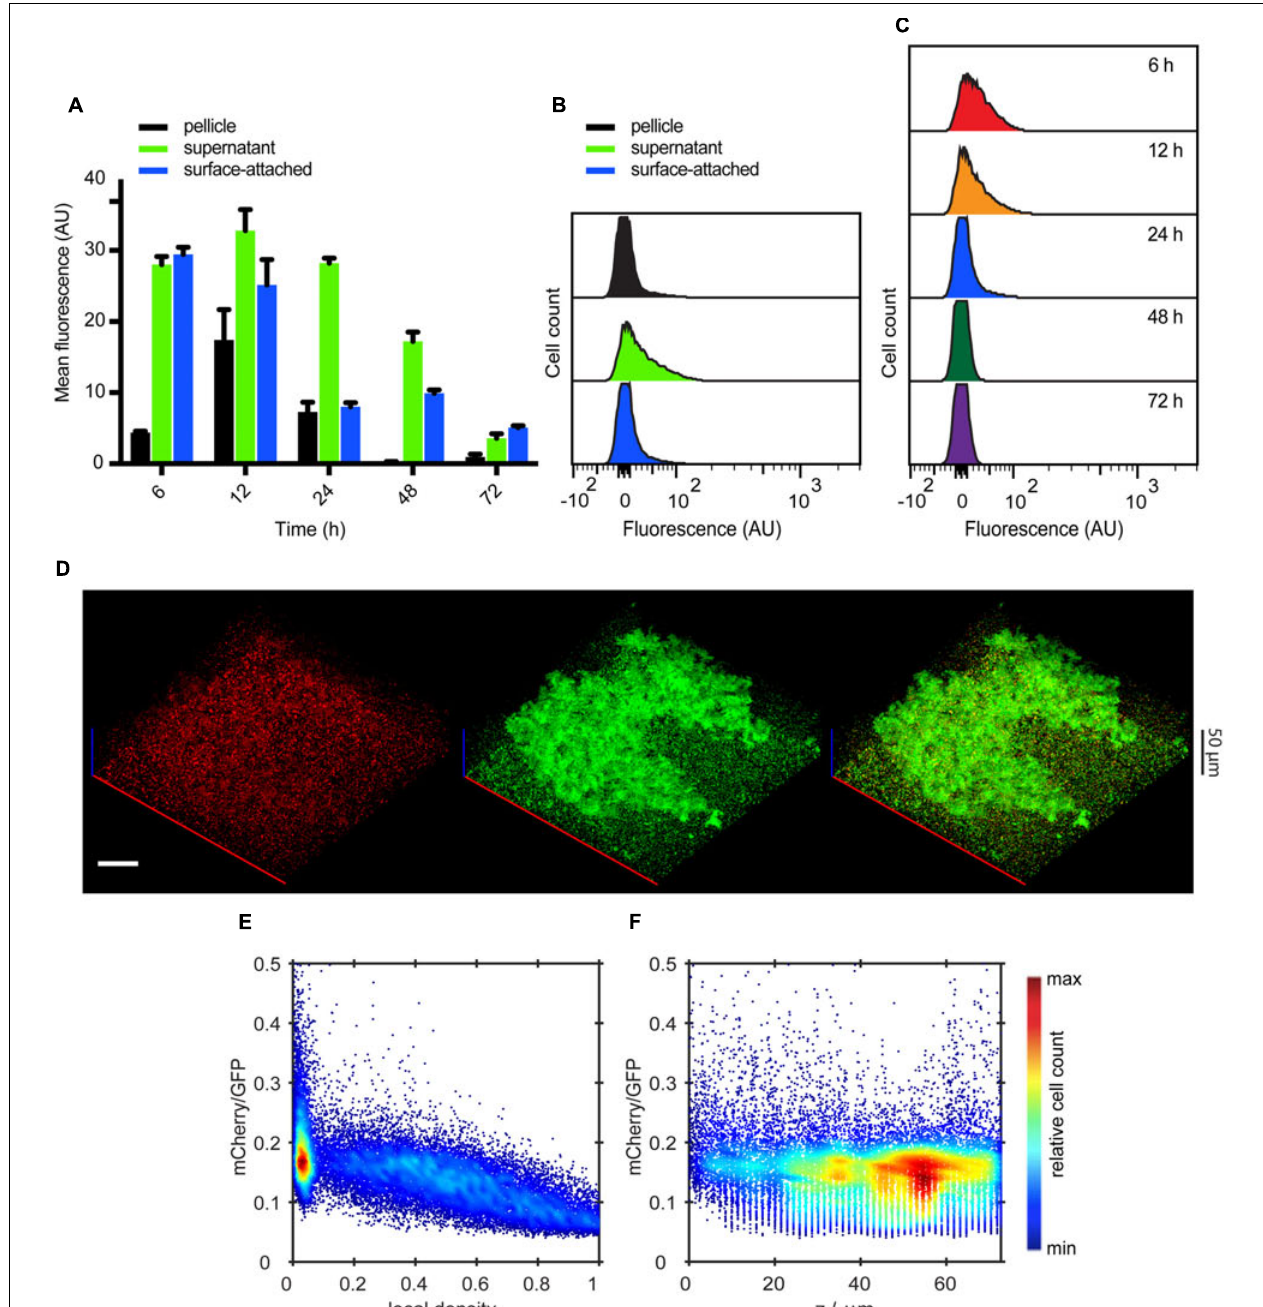
FIGURE 3 | Spatio-temporal expression of flagella in static submerged biofilms. (A) Mean of P fliC -mCherry fluorescence intensity measured in indicated cell fractions by flow cytometry. Shown are mean values calculated from three independent experiments and standard errors. (B) Flow cytometry analysis of P fliC -mCherry fluorescence detected in individual biofilm fractions at 24 h. (C) Changes in the single-cell expression of flagella measured over time in surface-attached cells. (D) Confocal fluorescence microscopy images (maximum projections) showing expression of P fliC -mCherry (red) in biofilms at 24 h. All cells were labeled with constitutively expressed eGFP (green) (pVM42). Scale bar, 40 µ m. (E,F) Expression profile of P fliC -mCherry as a function of local density (E) and along the height ( z -axis) of the biofilm (F) . Values of mCherry fluorescence are normalized to fluorescence of eGFP which labels all cells. The color scale shows relative cell count from lowest (blue) to highest